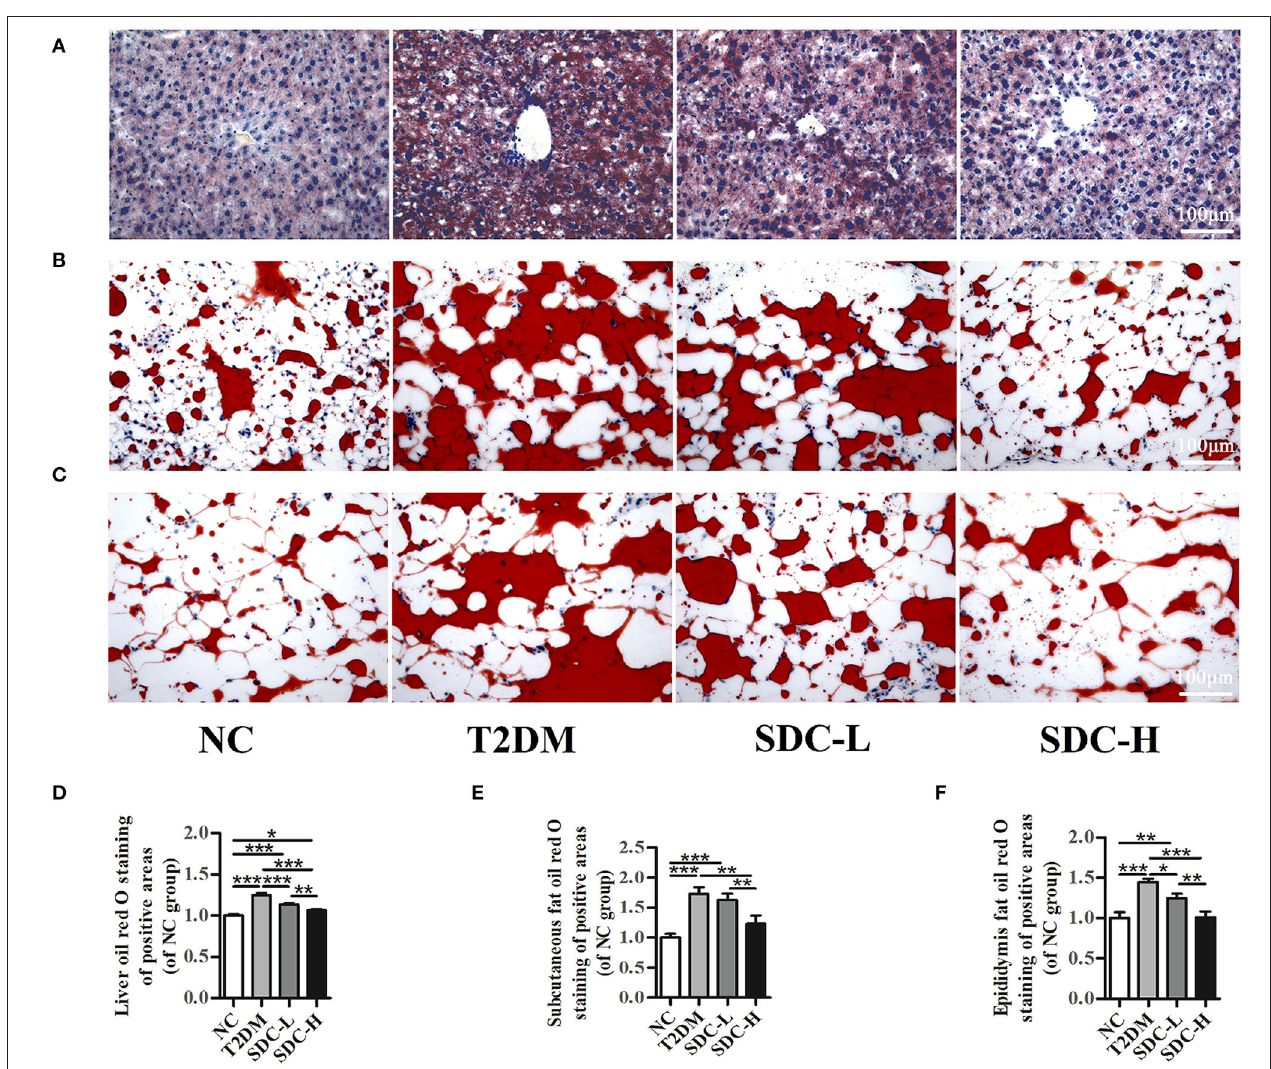
FIGURE 4 | Lipid accumulation in liver (A) , subcutaneous adipose (B) , and epididymal visceral adipose (C) ; Relative liver (D) , subcutaneous adipose (E) , and epididymal visceral adipose (F) oil red O red staining of positive areas. n = 5, * P < 0.05, ** P < 0.01, *** P <